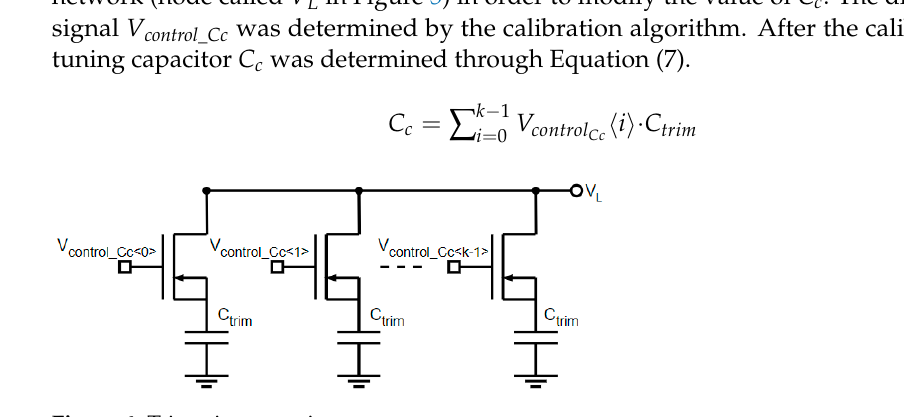
Figure 6. Trimming capacitor array.